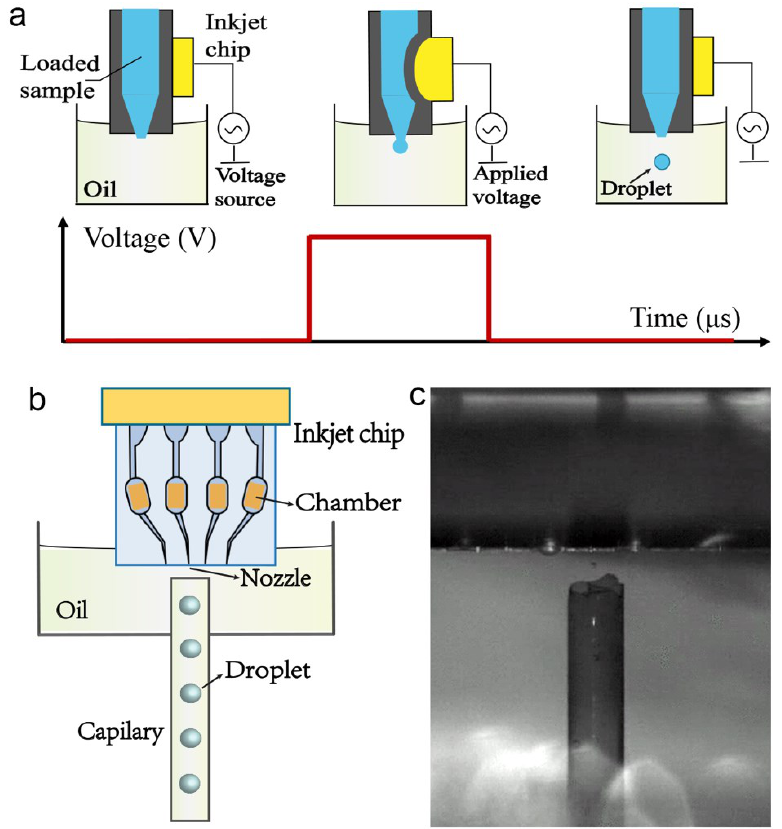
Figure 2. Droplet generation using inkjet printer. ( a ) Schematic illustration of a droplet generation cycle by piezoelectric inkjet printer. ( b ) Schematic illustration of droplets generation by inkjet printer. ( c ) Microscopic image of droplet injection by inkjet printer.